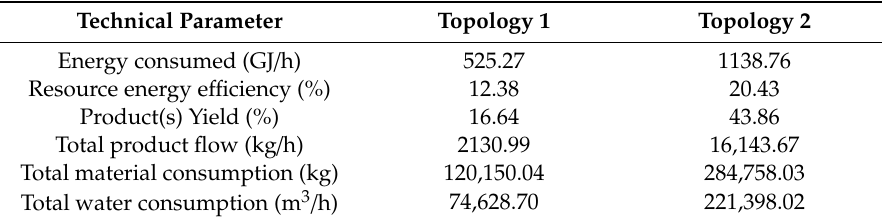
Table 9. Technical parameters for the evaluated